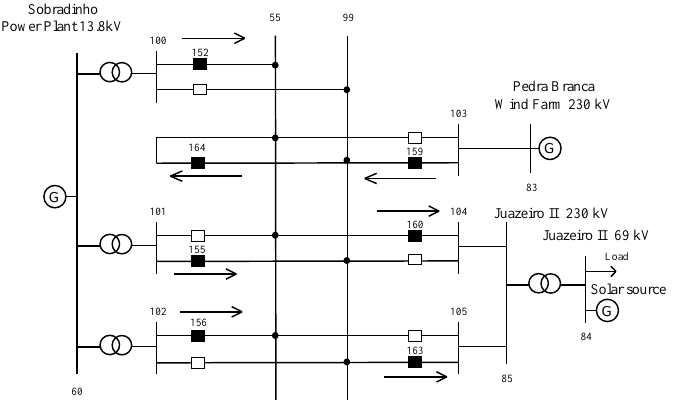
Figure 6. Power flow distribution at Sobradinho 230 kV substation.